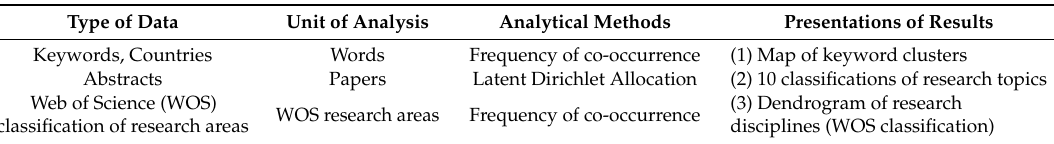
Table 1. Type of data, methods and the results.